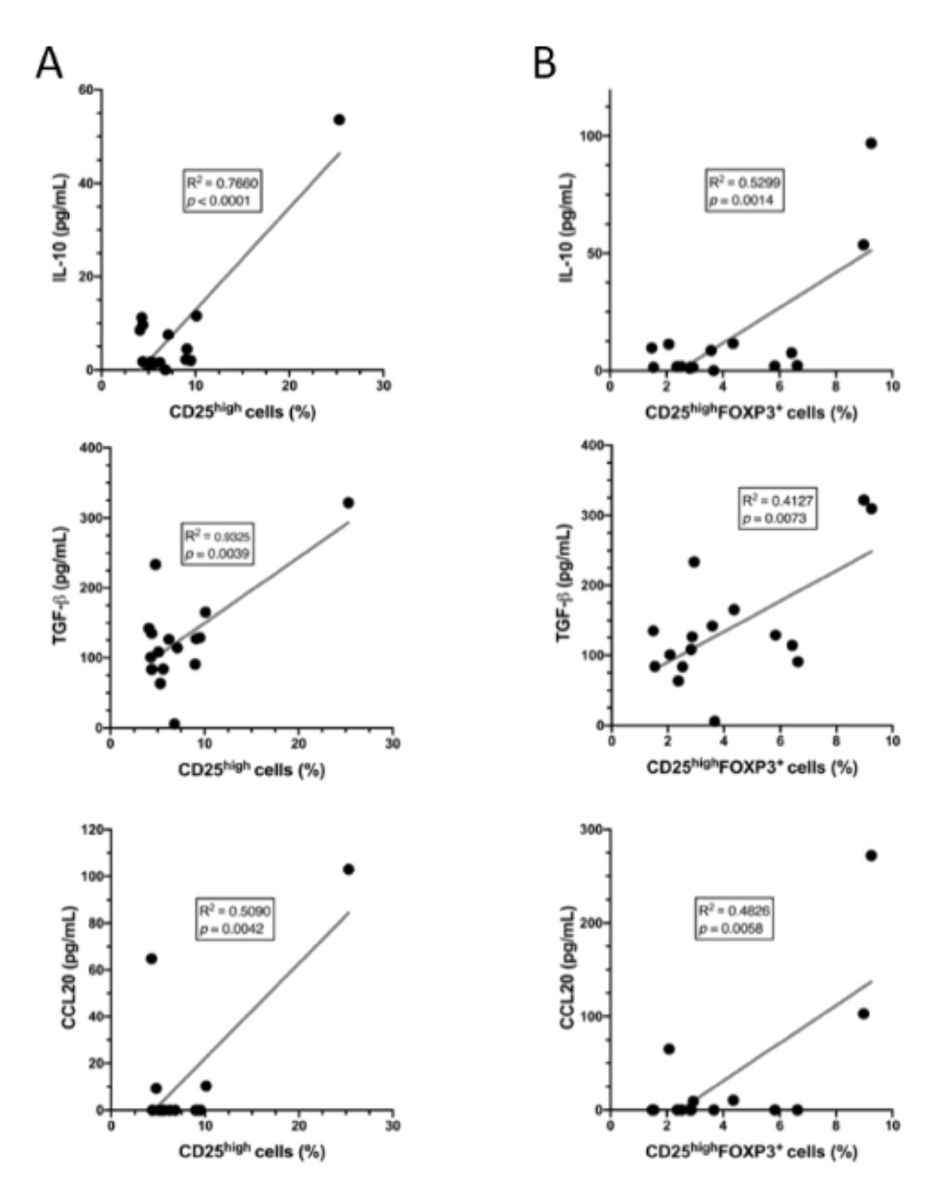
Figure 4. Correlations between the proportions of ( A ) CD25 high and ( B ) CD25 high FOXP3 + CD4 + T cells and the concentrations of IL-10, TGF- β 1/2, and CCL20 in the peritoneal fluid of women in the endometriosis and control groups. Correlations between the tested variables were computed by a linear regression analysis. Correlation coefficients (R 2 ) and p -values are shown in the